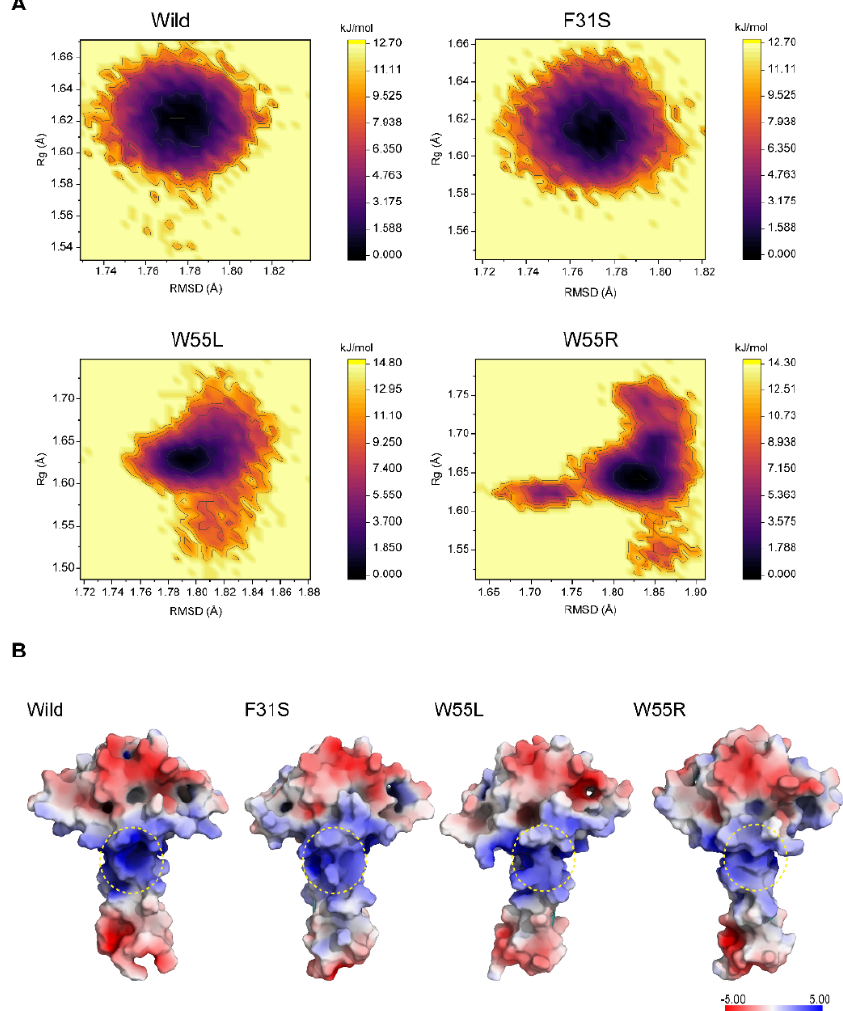
Figure 7. Variants containing structure showed a difference in the positive electrostatic potential in LIS1 structure. ( A ) Free energy landscapes were generated using RMSD and Rg as a reaction coordinate to find energy minimum for wild, F31S, W55L, and W55R, respectively. A color-coded map illustrates the energy state of the protein conformer, with dark purple color indicating a lower energy minimum and yellow indicating a high state. ( B ) The positive electrostatic potential near the dimerization site had been displayed as a surface map for the wild-type and all variants representative structure as determined by the free energy landscape (FEL). A deeper blue zone denotes more electropositive area (>5 kT/e), whereas a red region shows a negative area ( − 5 kT/e), and a yellow dotted line shows the dimerization site.